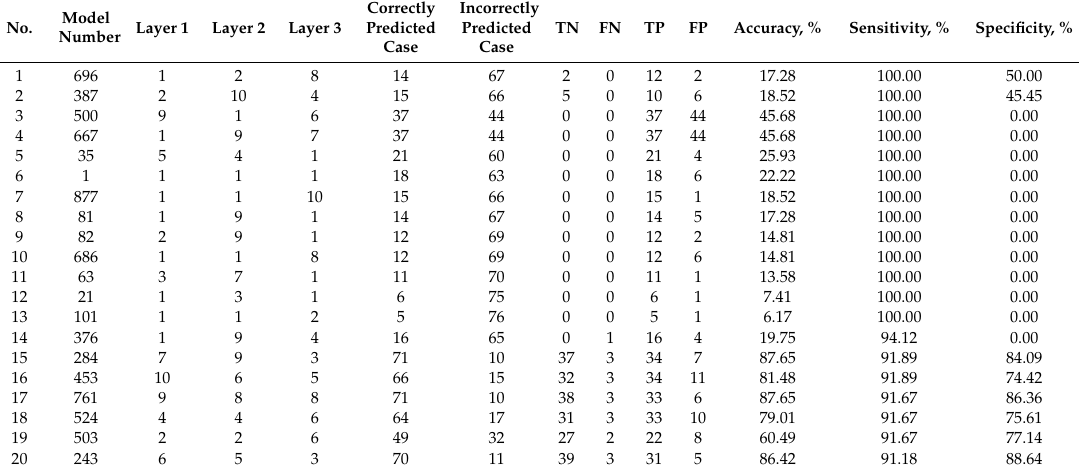
Table 13. Top twenty “Sensitivity” results for the hyperbolic tangent activation function ANN models.